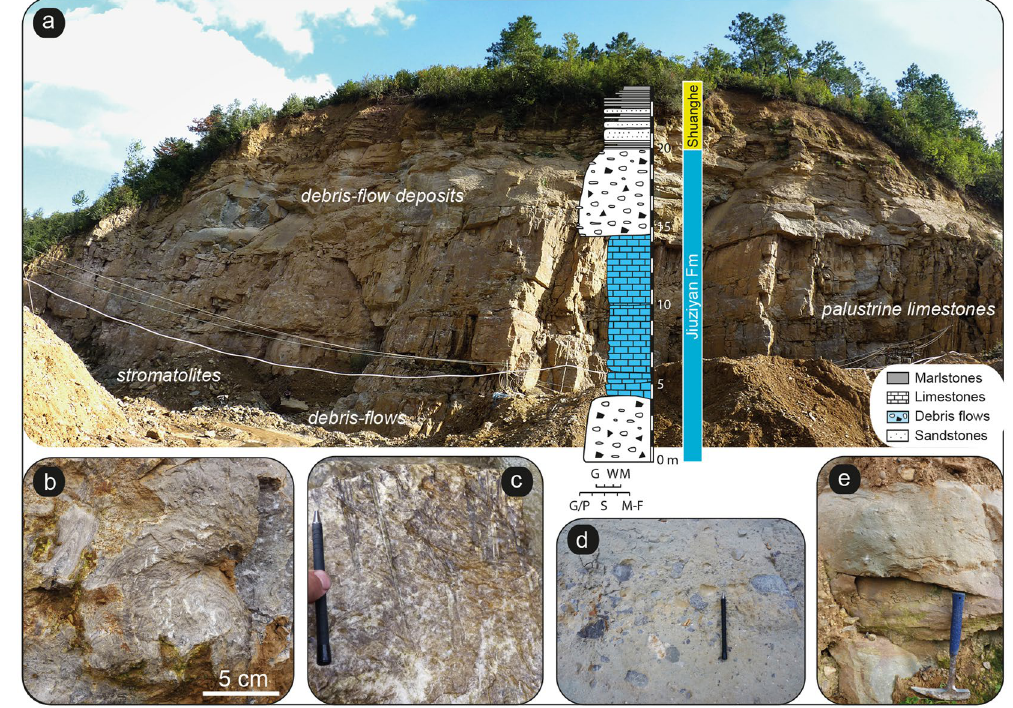
Figure 3. The fluvio-palustrine-lacustrine succession of the Jiuziyan Fm. (site S254). ( a ) Sedimentary succession showing the alternation between palustrine limestones and overlying massive debris-flow deposits (e.g., matrix-supported conglomerates) associated to massive high-energy floods in palustrine-sublacustrine settings. The abbreviations used for the textural scale are: ‘M-F’: marls and fines (siliciclastic mudstones); ‘S’: sands; ‘G-P’: gravels and pebbles; ‘M’: mudstones; ‘W’: wackestones; ‘G’: grainstones. ( b ) In situ decimeter-sized domical stromatolites (facies Str). Stromatolites grew in calm, ponded areas of the palustrine-lacustrine system. ( c ) Boundstone of stems (e.g., phytoherm tufa of stems, facies Phs). ( d ) Debris-flow deposits (calcisiltites/ calcilutites) including angular to subangular carbonate lithoclasts, as floating rafts in argillaceous